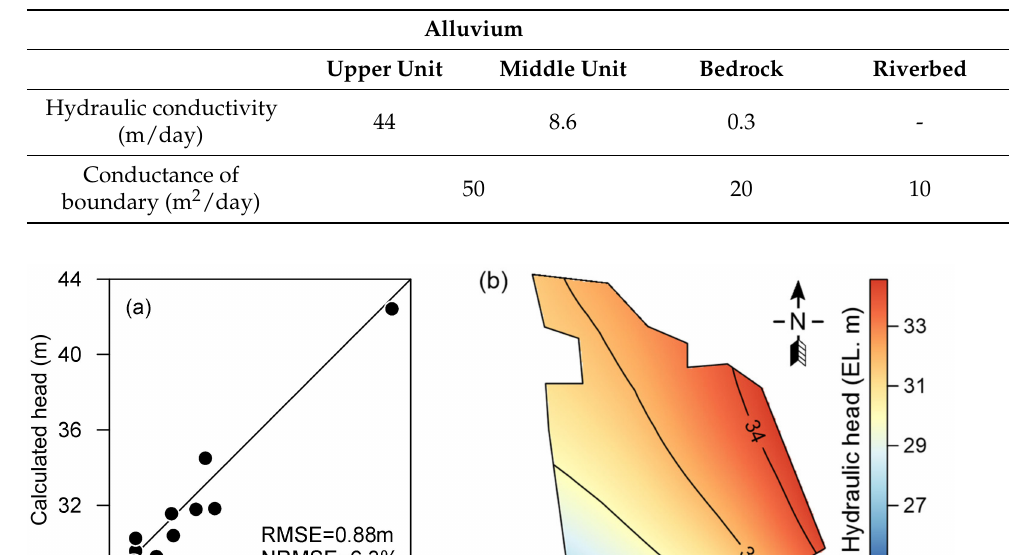
Table 2. Hydraulic parameter values used in the model.